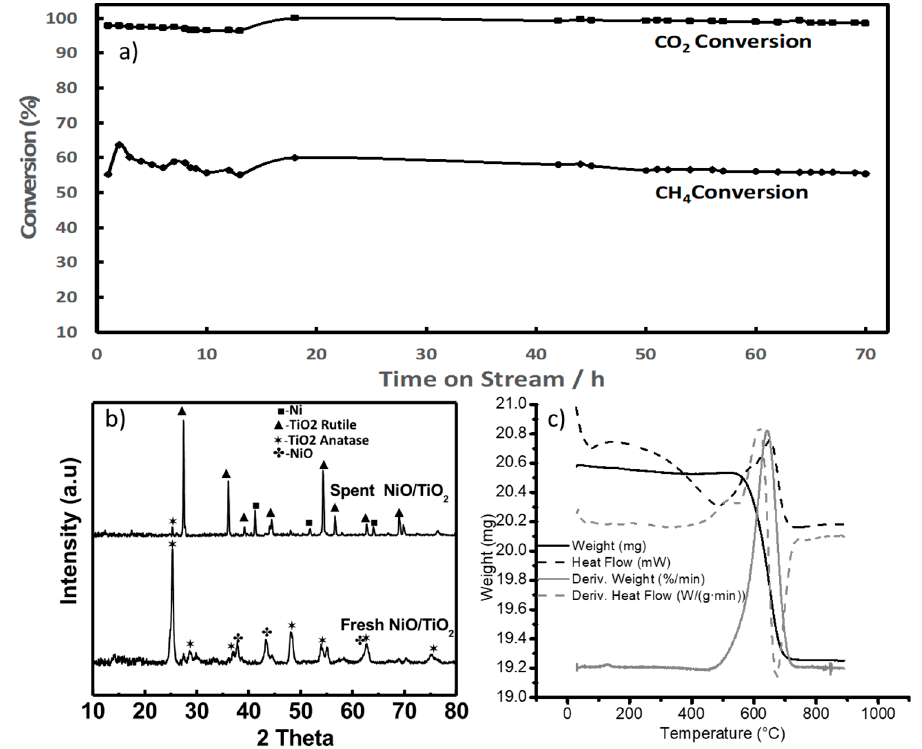
Figure 6. ( a , d ) Low- and ( b , e ) high-magnification TEM images and ( c , f ) EDS elemental maps of fresh and spent nanowire catalyst sample.